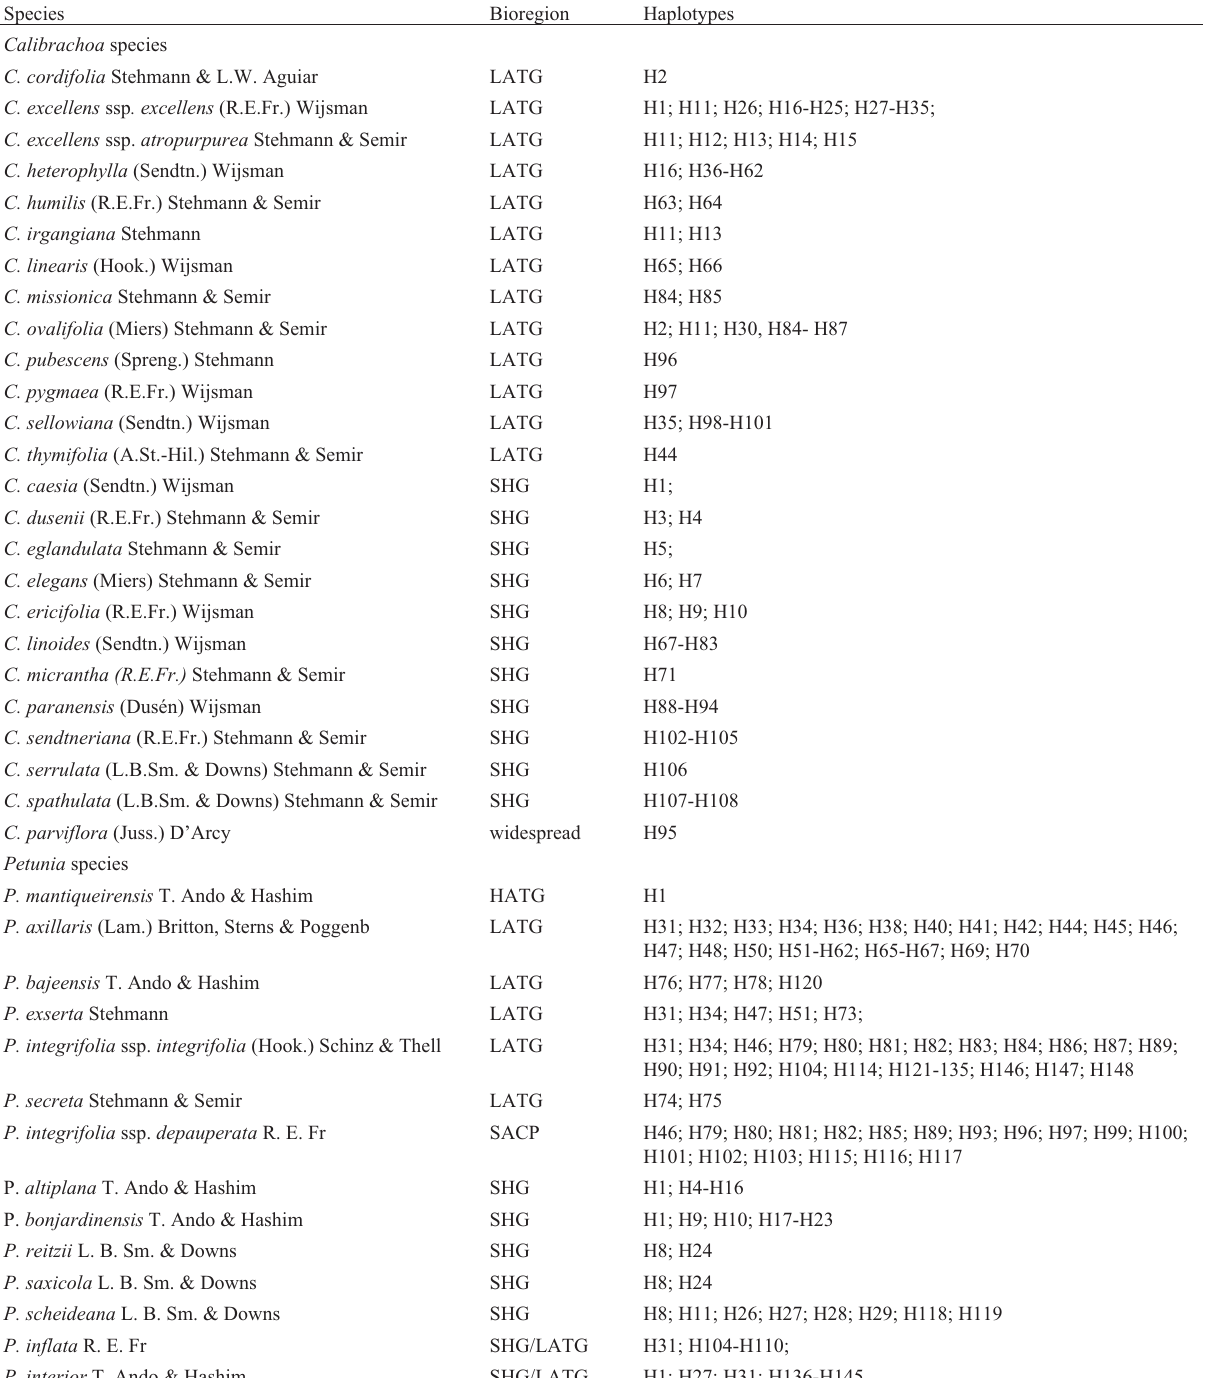
Table 3 - Plastid haplotypes for Calibrachoa and Petunia species based on combined sequences of intergenic regions trnS-trnG and trnH-psbA.